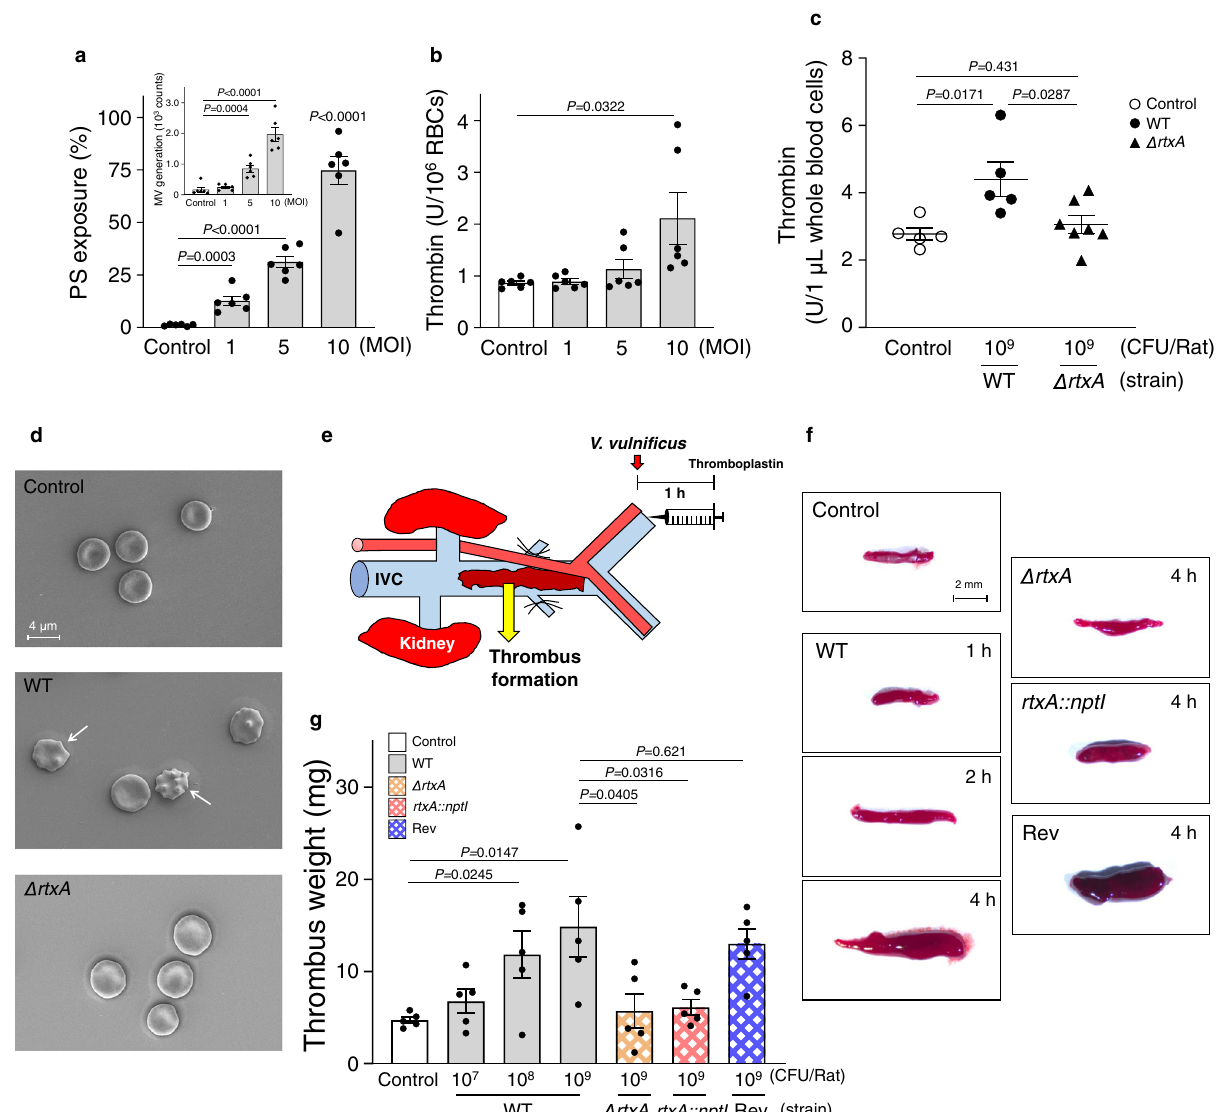
Fig.4|The V.vulni fi cus MARTXtoxinisresponsibleforratvenousthrombosis. a , b Rat RBCs were infected with V. vulni fi cus at the indicated MOIs and incubated for10min,andthenPSexposureandMVgeneration( a ,insert)( a )( n =6,two-tailed Student ’ s t -test), and thrombin generation ( b ) ( n =6, two-tailed Student ’ s t -test) were determined. c Rats were infected IV with either V. vulni fi cus WT or Δ rtxA mutant(10 9 CFU/Rat)for1h,andthenwholebloodcellswerecollectedandusedto determine thrombin generation ex vivo ( n =5 in control, n =5 in WT, n =7 in Δ rtxA mutant, two-tailed Student ’ s t -test). d RatswereinfectedIV witheither V.vulni fi cus WTor Δ rtxA mutant(10 8 CFU/Rat)for1h,andthenwholebloodcellswerecollected and removed platelet-rich plasma and buffy coat to observe RBCs morphology using SEM. The representative images by SEM images among fi ve independent experimentswerepresented.Thewhitearrowindicatesechinocyte.Thescalebaris presented. e A schematic diagram presents the isolation of thrombus formed